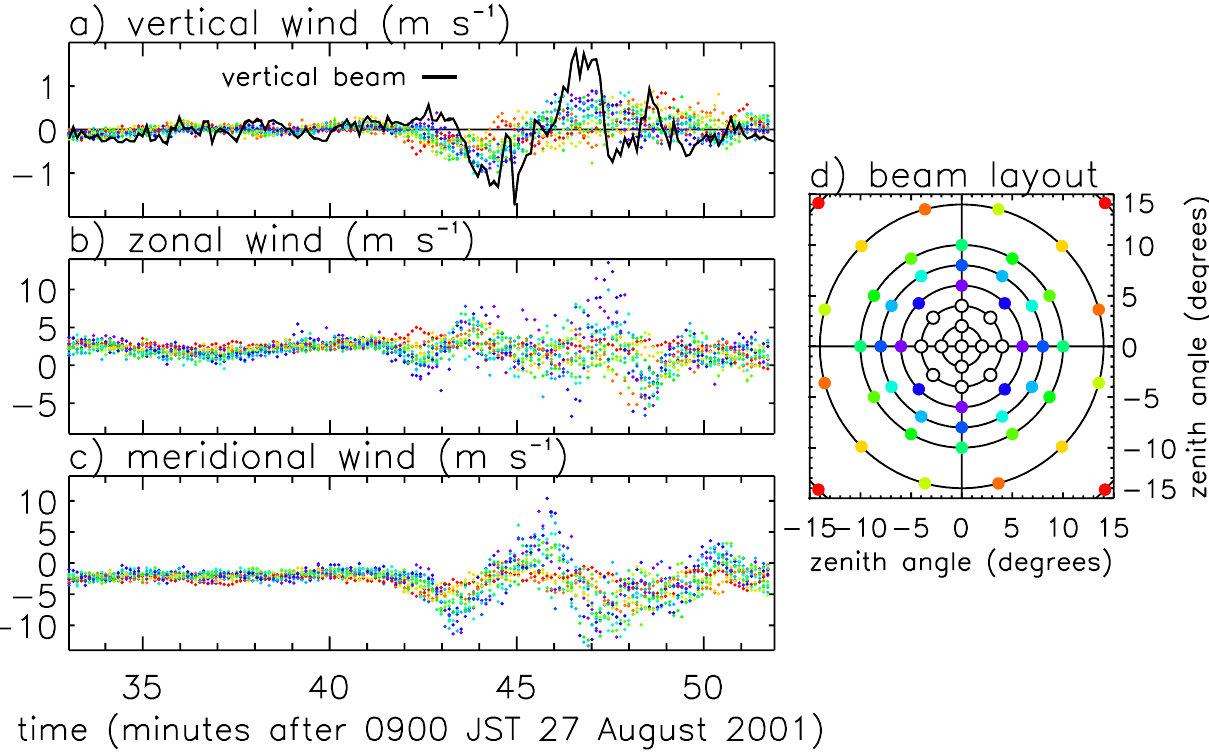
Fig. 8. (a) Vertical, (b) zonal and (c) meridional wind at 1.425km AGL from (d) 12 sets of four beams. A convective cell passes through at ∼ 09:42–09:52 JST. Solid line in (a) shows two (overlapping) vertical-beam measurements of vertical wind as a reference.